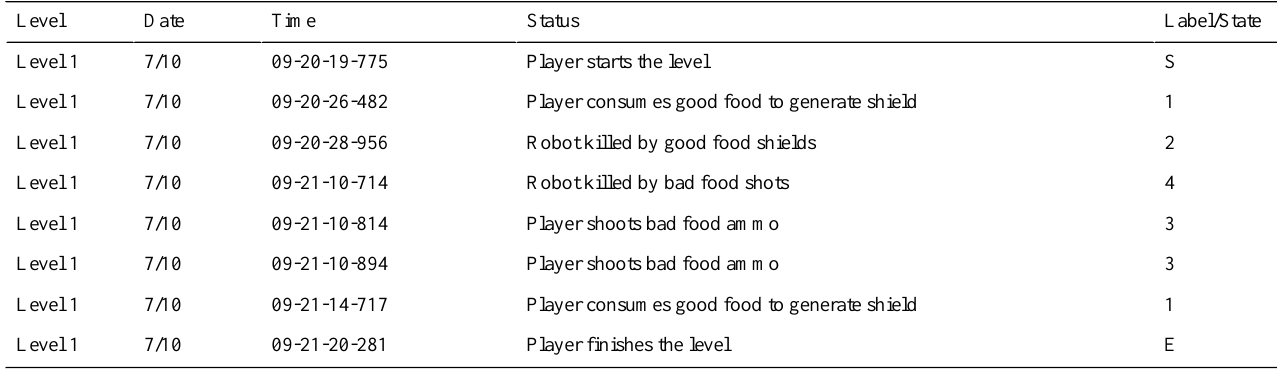
Table 3. Example of timestamped data and labeling producing sequence